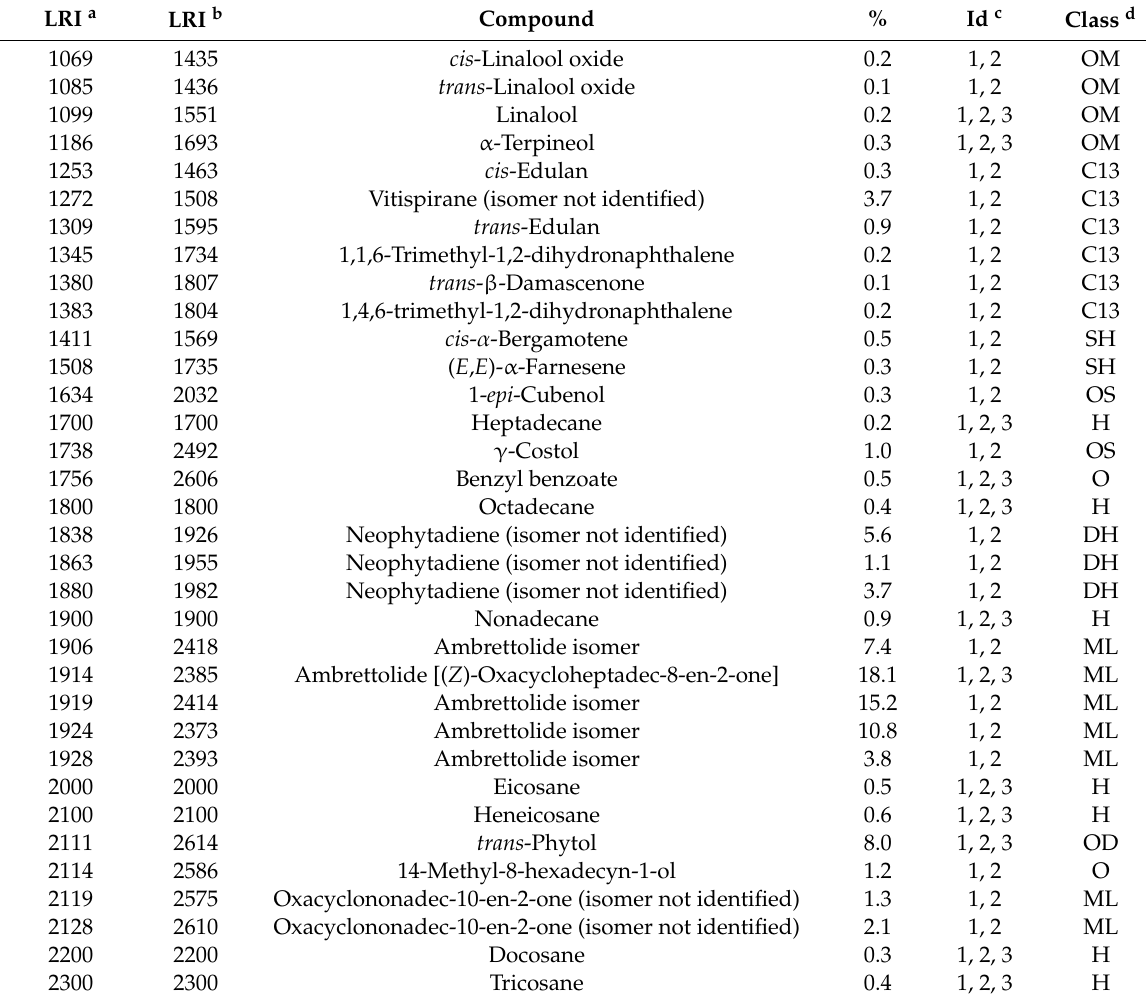
Table 1. Chemical composition of A. procera essential